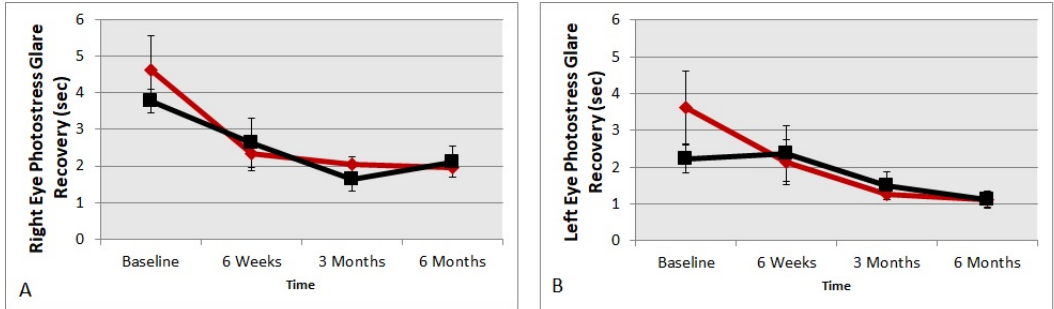
Figure 2. DD2 glare recovery improvement. Photo stress glare recovery data in seconds using the MDD2 device. A = right eye; B = left eye. The red diamond symbols represent the treatment group and black square symbols represent the placebo group.